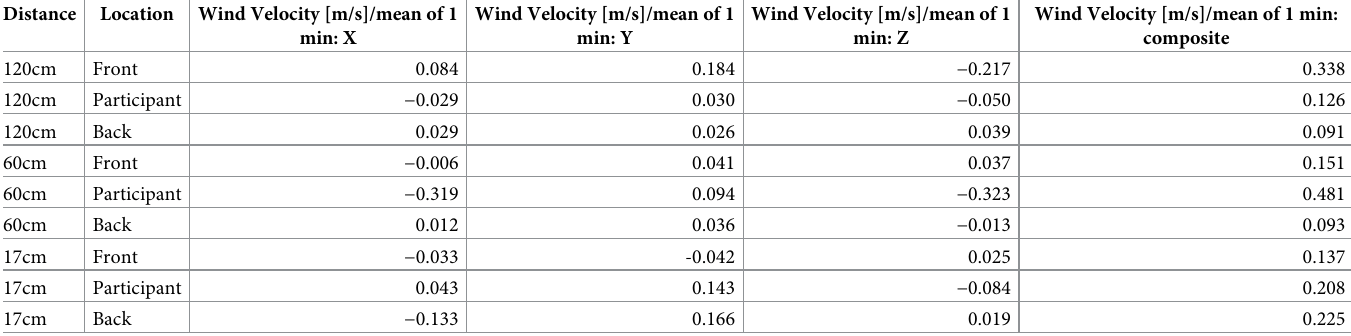
Table 1. Wind velocity under the direct